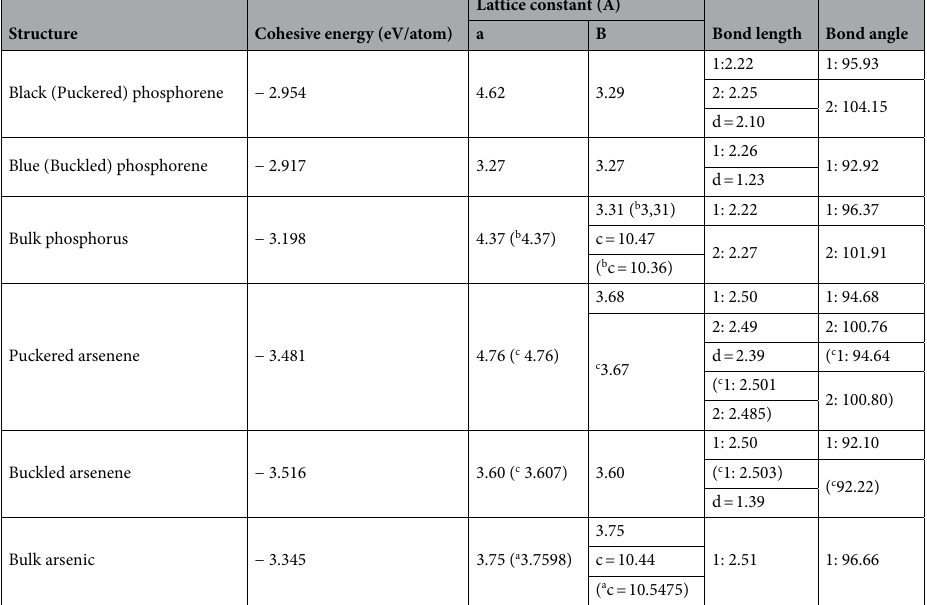
Table 1. Structural parameters and cohesive energies of puckered and buckled phosphorene and arsenene. Parameters of black phosphorous and gray arsenic are also presented. Bulk experimental values are taken from (a) Ref. 63 and (b) Ref. 64 . Previous arsenene values are taken from Ref. 16 .